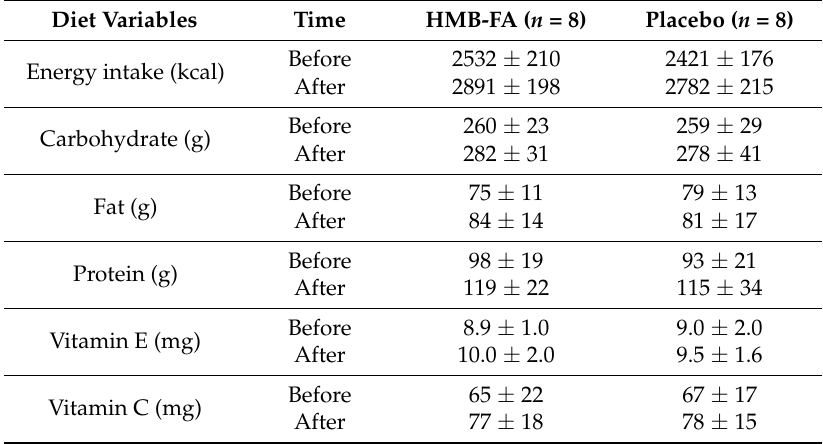
Table 1. Dietary intake assessed for the beta-hydroxy-beta methylbutyrate-free acid (HMB-FA) and placebo supplementation groups before and after the training period. Data are presented as means ±